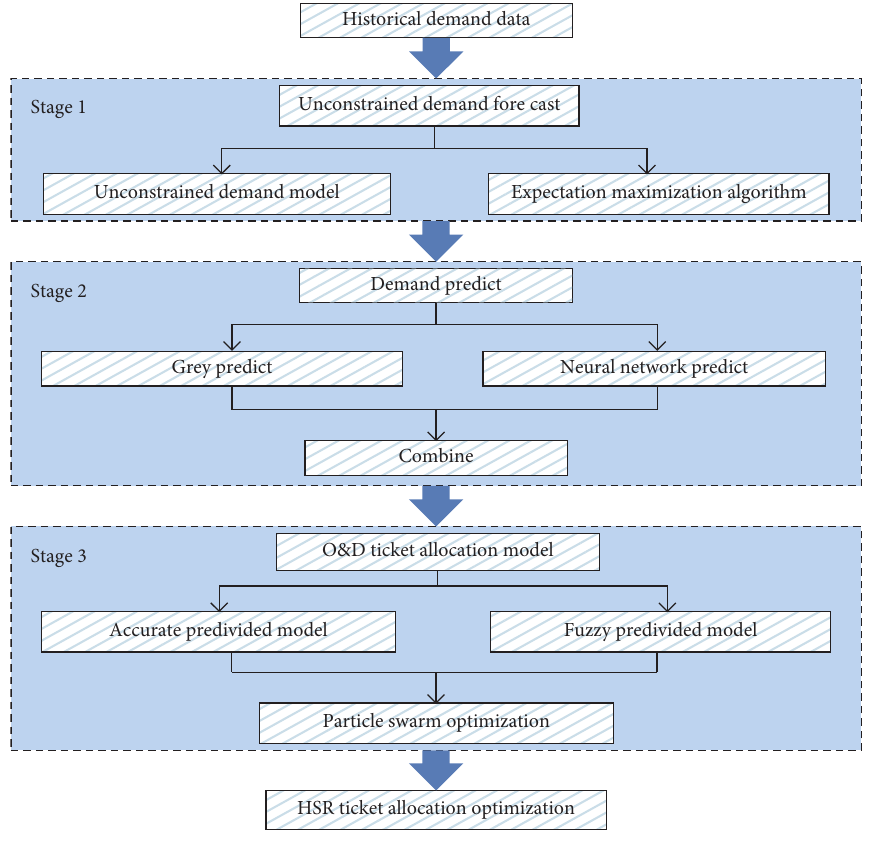
Figure 3: Process of HSR ticket allocation optimization method. Table 1: The meaning of unconstrained demand model symbol in high-speed rail passenger